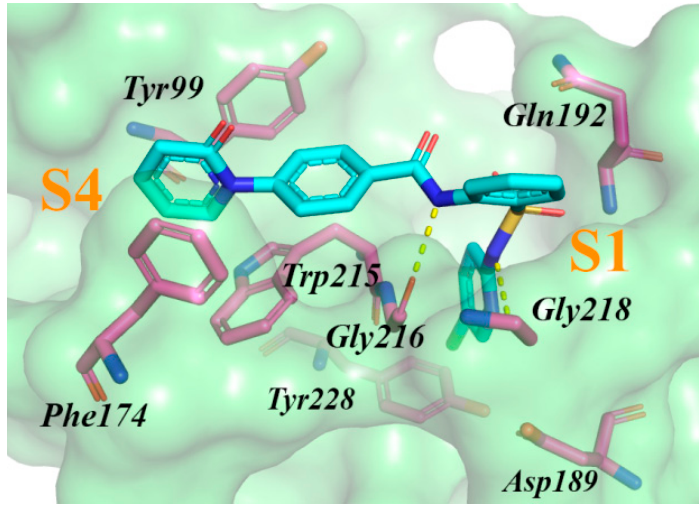
Figure 1. The active site of FXa with a bound nanomolar inhibitor (PDB ID: 3CEN). Hydrogen bonds are shown as yellow dotted lines. Buried residues are labeled by the lower font size.